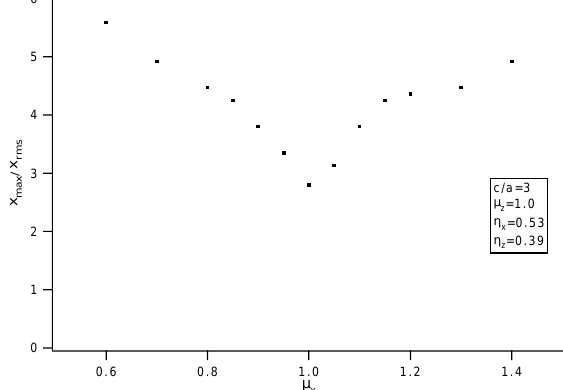
FIG. 15. Extent of the longitudinal halo for the 6D stationary distribution with zero transverse mismatch m (cid:120) (cid:173) m (cid:121) (cid:173) (cid:49)(cid:46)(cid:48) ( (cid:99) (cid:121) (cid:97) (cid:173) (cid:51)(cid:44) h (cid:120) (cid:173) (cid:48)(cid:46)(cid:54)(cid:53)(cid:44) h (cid:122) (cid:173) (cid:48)(cid:46)(cid:52)(cid:57) ).